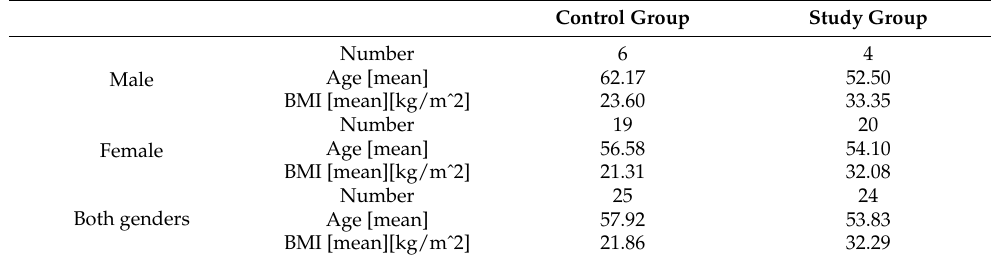
Table 2. Anthropometric data of